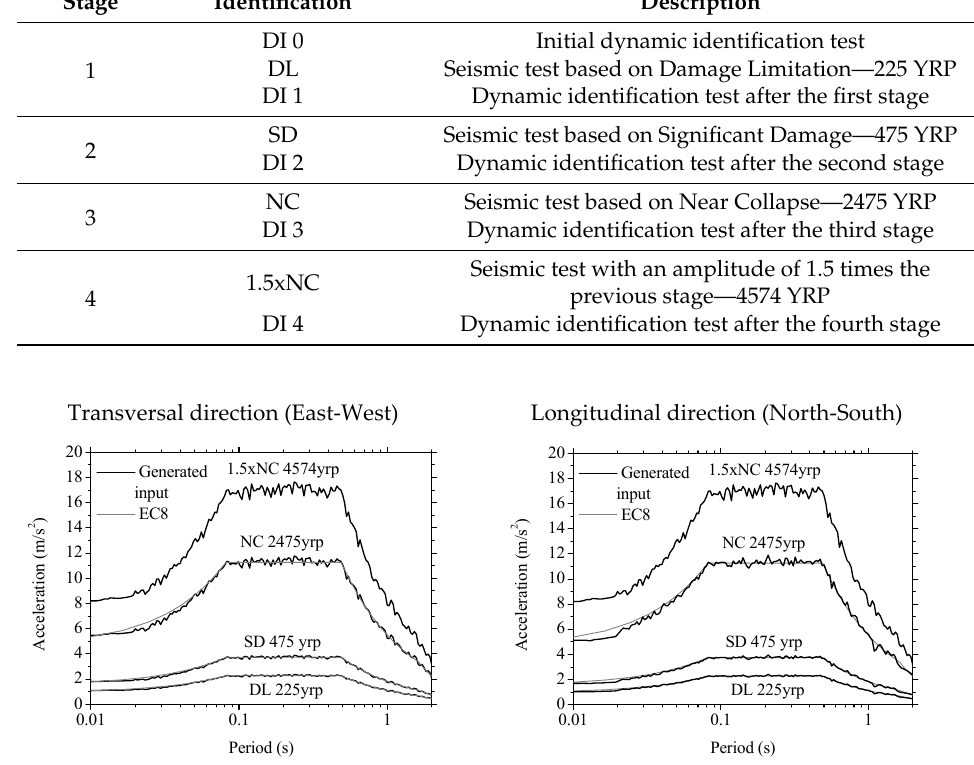
Figure 8. Comparison between the pseudo-acceleration response spectra of the accelerograms gen- erated and the response spectra obtained from EC8 (scaled).